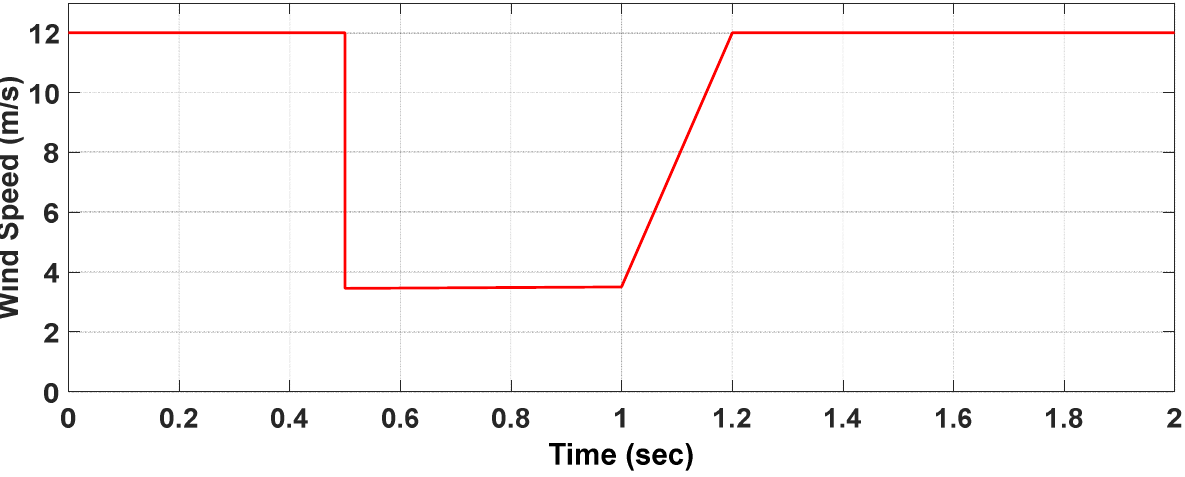
Figure 3. WS Test Pattern (in m/s) used for Simulation Analysis. Tables 2 and 5 show the specs of the Proton Exchange Membrane Fuel Cell (PEM-FC) framework with a simulated boost converter. The model of a PEM-FC framework consists of a boost converter, load, and P-&-O controller. Table 5. Specifications of PEM-FC Module.